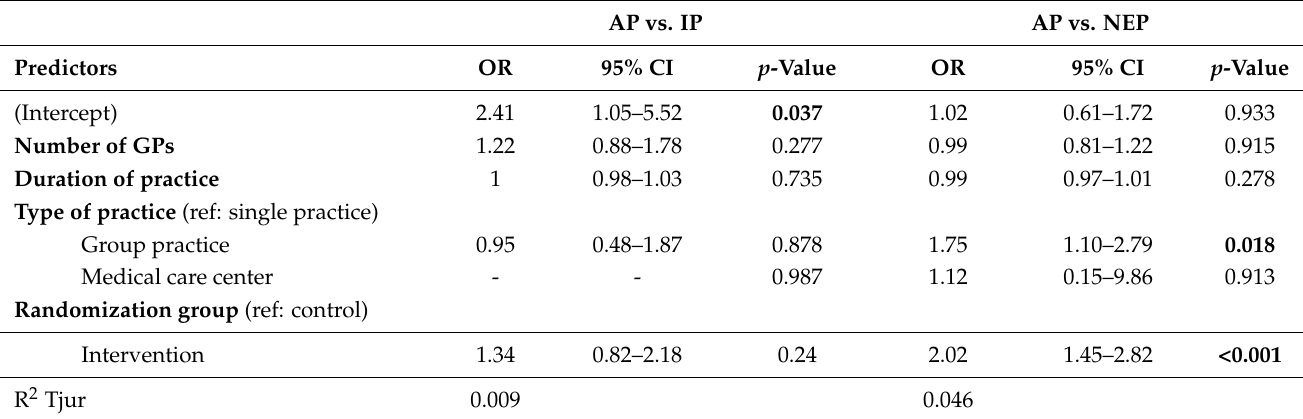
Table 3. Factors related to the chance of belonging to AP versus IP and AP versus NEP practices. AP vs.